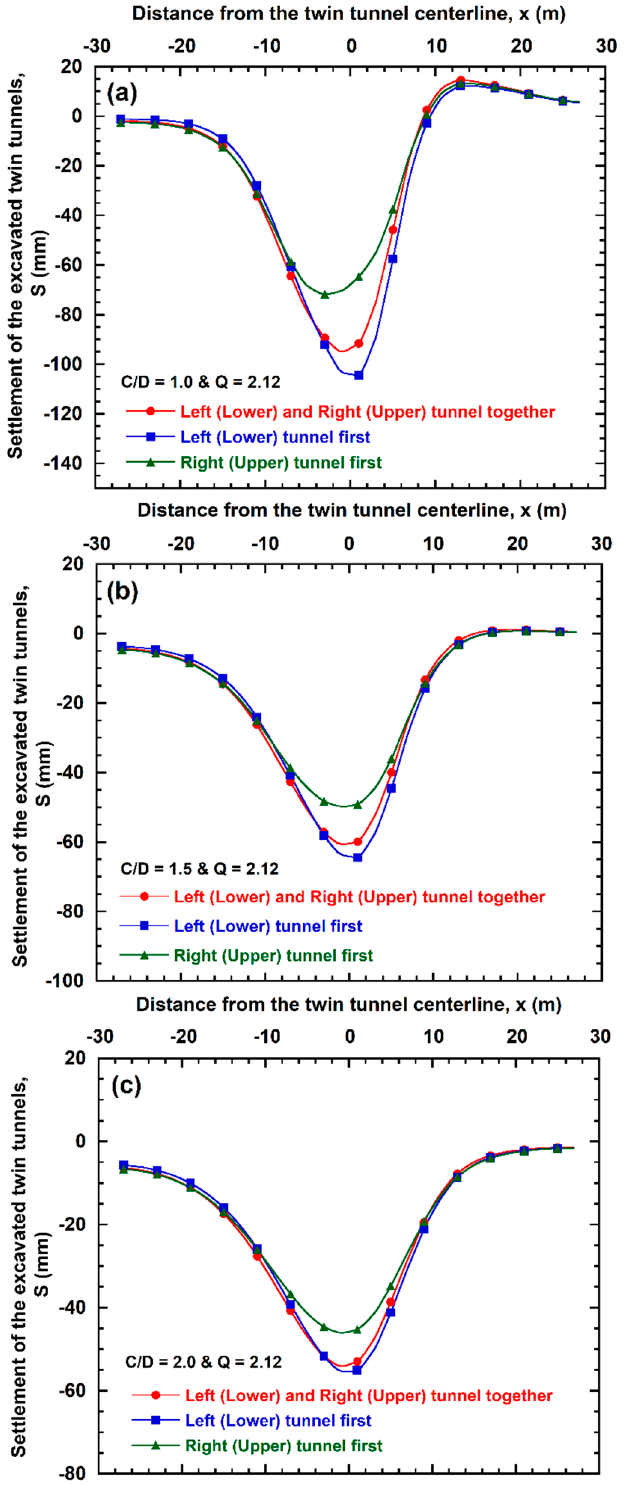
Figure 19. Effect of excavation sequence on total surface settlement caused by offset arrangement twin tunnels ( a – c ).